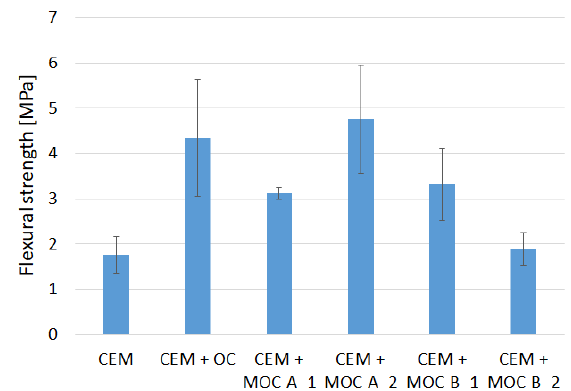
Figure 5. Flexural strength of tested samples.